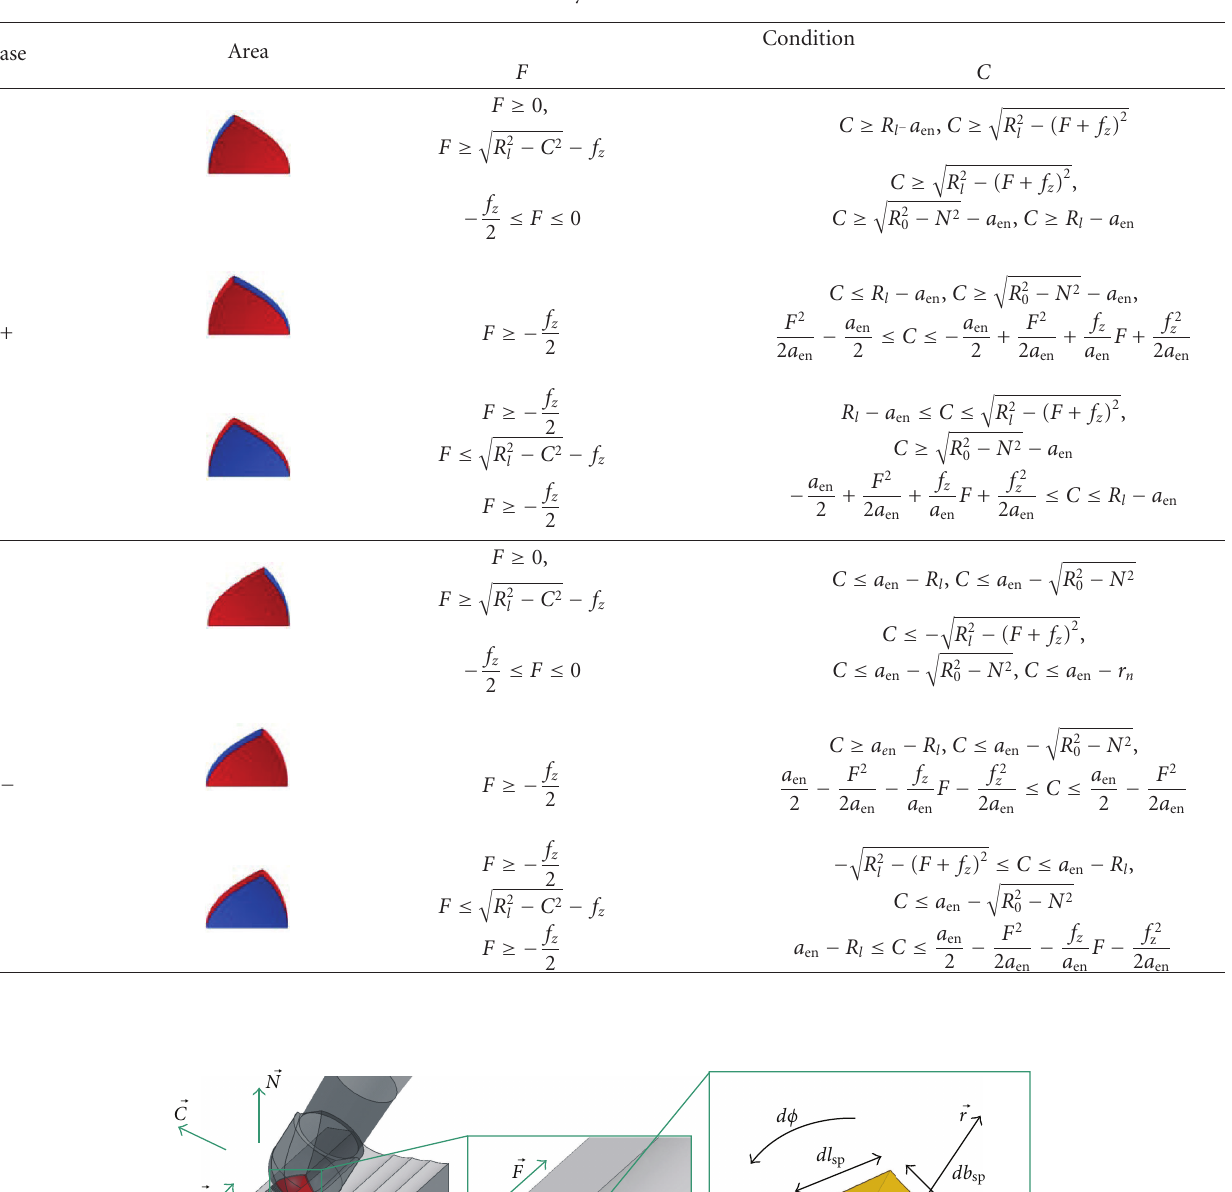
Table 3: Boundary curves for the case C+.